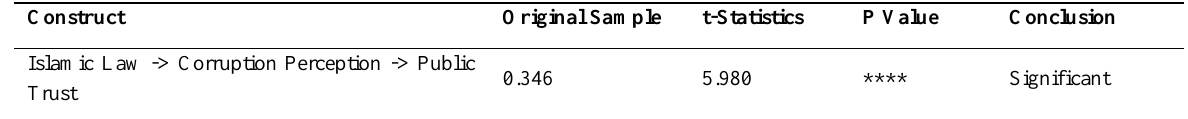
Table 7: Indirect Effect Test